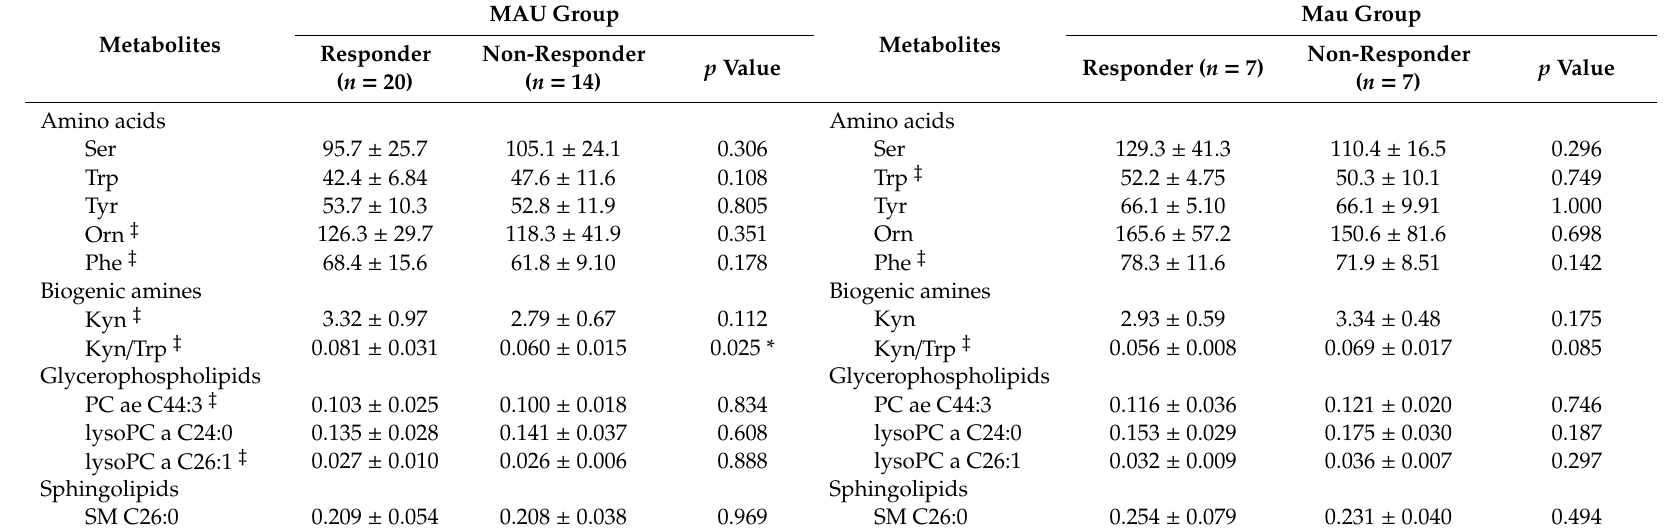
Table 3. Metabolites associated with angiotensin receptor blocker responsiveness in 48 T2DM patients with various stages of